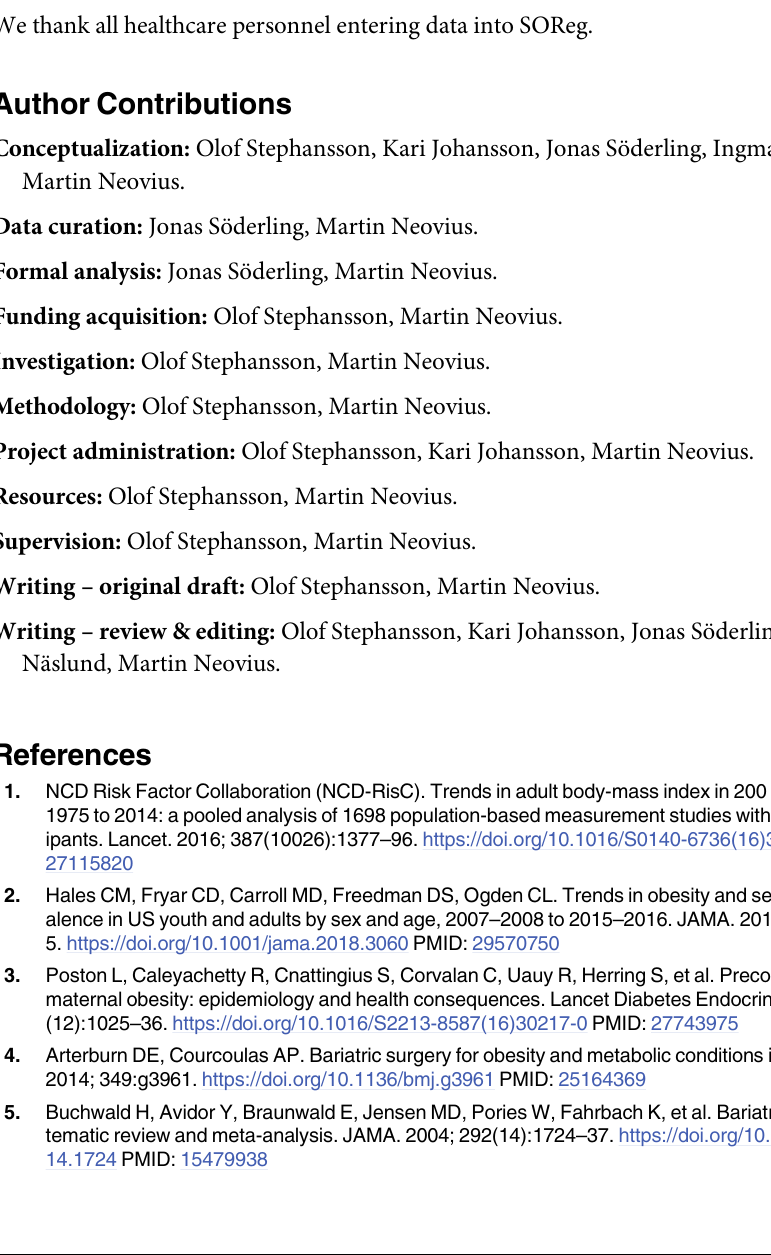
S3 Fig. Delivery outcomes in the general population, after bariatric surgery, and in matched general population controls. S1 Table. Mediation analysis including birth weight (continuous variable) in delivery out- comes. S2 Table. Delivery outcomes of the first singleton live term birth in women in Sweden between 2006 and